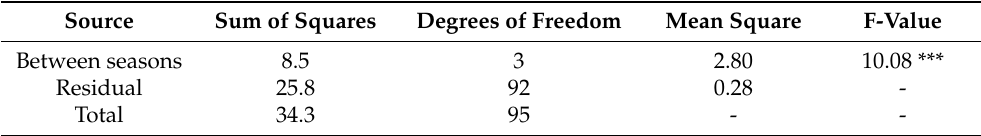
Table 8. Results of F-test for seasonality in number of residential units completed (NRC) of time series. Source Sum of Squares Degrees of Freedom Mean Square F-Value Between seasons 8.5 3 2.80 10.08 *** Residual 25.8 92 0.28 - Total 34.3 95 - - Denote: *** significant at the 0.001